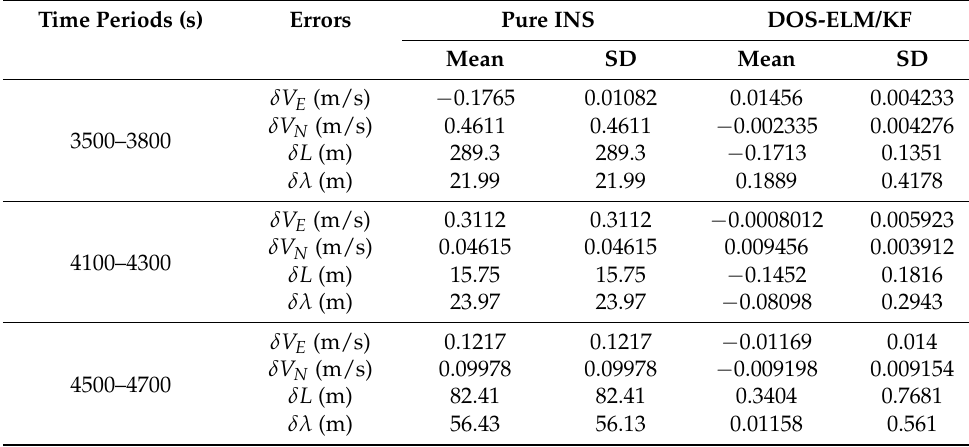
Figure 10. Comparison of speed/errors between DOS-ELM-aided and pure INS methods during GPS outage #3 in the vehicle-mounted experiment. ( a ) Eastern and northern speed errors of DOS-ELM-aided and pure INS methods during GPS outage #3 in the vehicle-mounted experiment. ( b ) Eastern and northern position errors of DOS-ELM-aided and pure INS methods during GPS outage #3 in the vehicle-mounted experiment. Table 2. Navigation results of pure INS and DOS-ELM-aided methods.